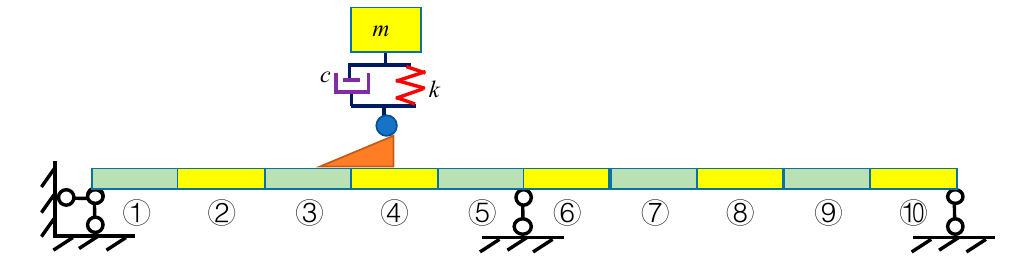
Figure 7. Two ‐ span continuous bridge with a 1 ‐ DOF vehicle model. Figure 7. Two-span continuous bridge with a 1-DOF vehicle